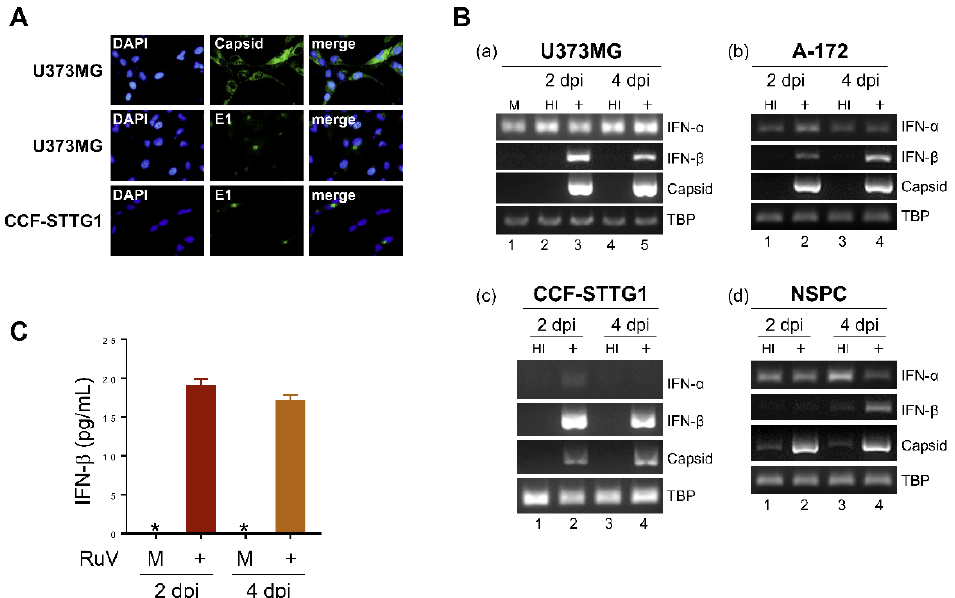
Figure 1. RuV infects human neural cell lines and induces IFN- β production. ( A ) Indirect immunofluorescence assay on U373MG cells and CCF-STTG1 cells infected with RuV RA27/3 strain. Infected cells at 3 days postinfection (dpi) were immunostained for RuV-encoded capsid or E1 proteins (green). DAPI was used for nuclear staining (blue). Images were acquired at a magnification of 40× objective lens. ( B ) Total RNAs extracted from neural cell lines U373MG ( a ), A-172 ( b ), CCF-STTG1 ( c ), and iPSC-derived NSPCs ( d ) that were uninfected (mock, M) or infected with RuV RA27/3 strain (+) or heat-inactivated RuV RA27/3 strain (HI) at 2 and 4 dpi (multiplicity of infection [MOI] of 1.8) were subjected to RT-PCR for the detection of IFN- α and IFN- β mRNAs and RuV RNAs encoding the capsid protein. TATA-box binding protein (TBP) mRNA was analyzed as a reference. The PCR products were analyzed by agarose gel electrophoresis. ( C ) Culture supernatants of U373MG cells that were uninfected (M) or infected with RuV RA27/3 strain (+) were collected at 2 and 4 dpi, and the concentration of IFN- β was measured by ELISA. Data are shown as means ± SEM of duplicate wells from one of two similar experiments. * indicates out-of-range.